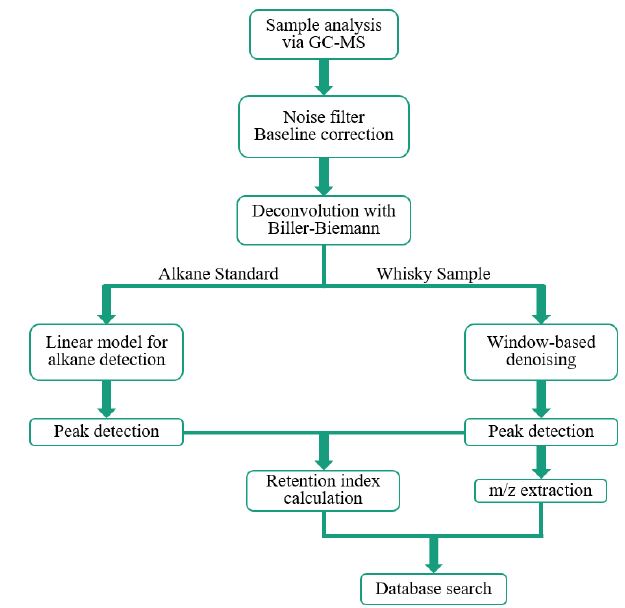
Figure 3. Schematic depiction of data flux and steps in processing and analyzing GC-MS data via the semi-automated